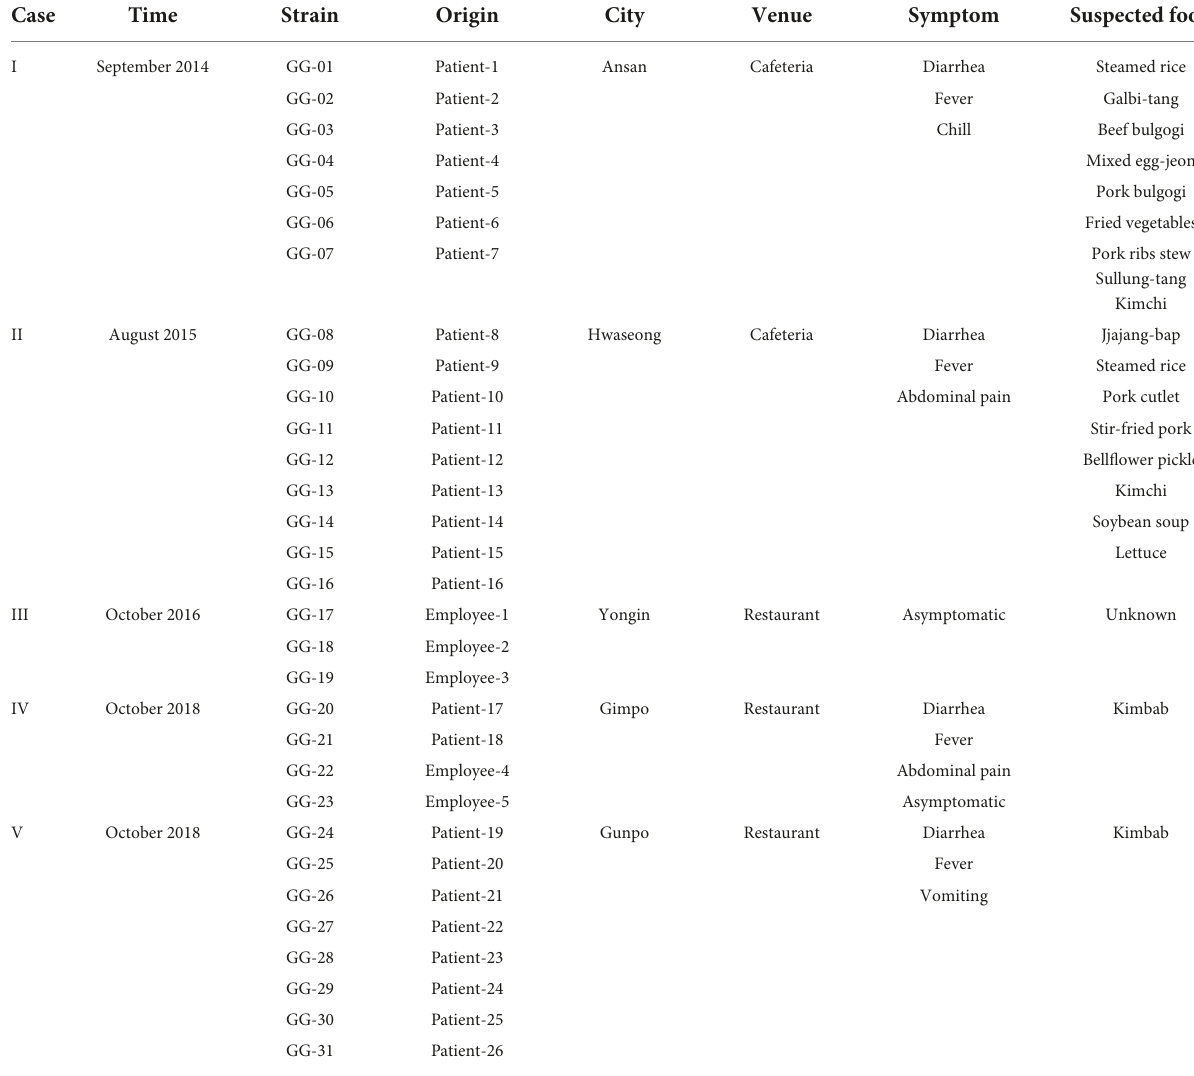
TABLE 1 Summary of 31 Salmonella Bareilly outbreak strains isolated in Gyeonggi-do, South Korea from 2014 to